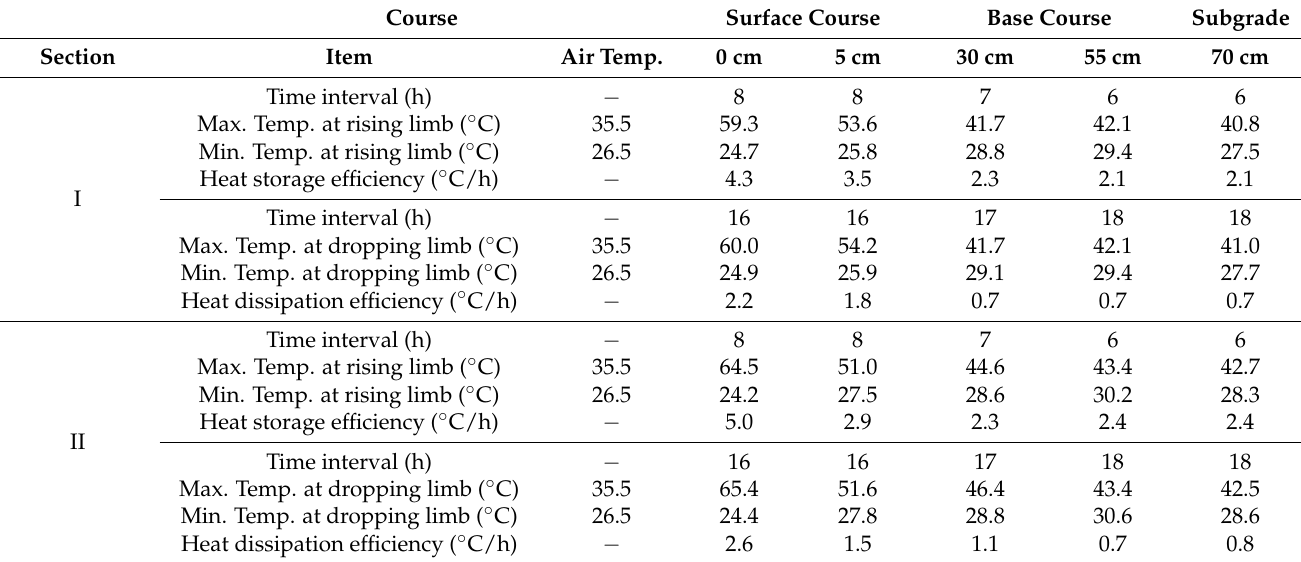
Table 5. Heat storage and dissipation efficiencies in 21th–25th